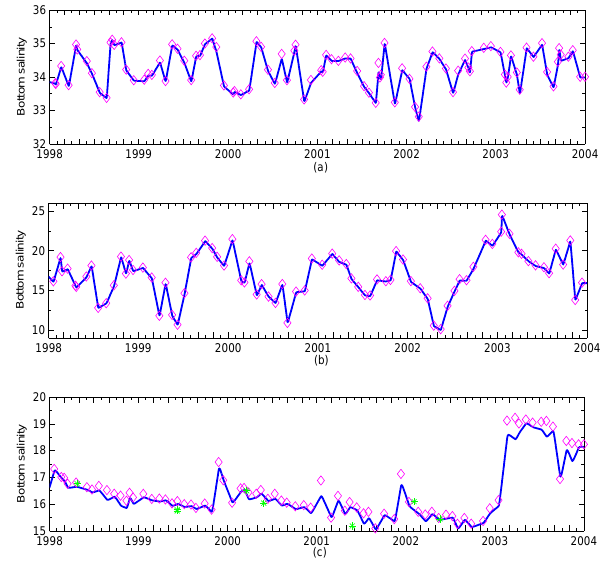
Fig. 10. Time series of bottom salinity for a six year period. Calcu- lated results are presented with a thick solid blue line, observation data of BED with magenta squares and FIMR data with green aster- isks. (a) – at FS; (b) – at AS; (c) – at